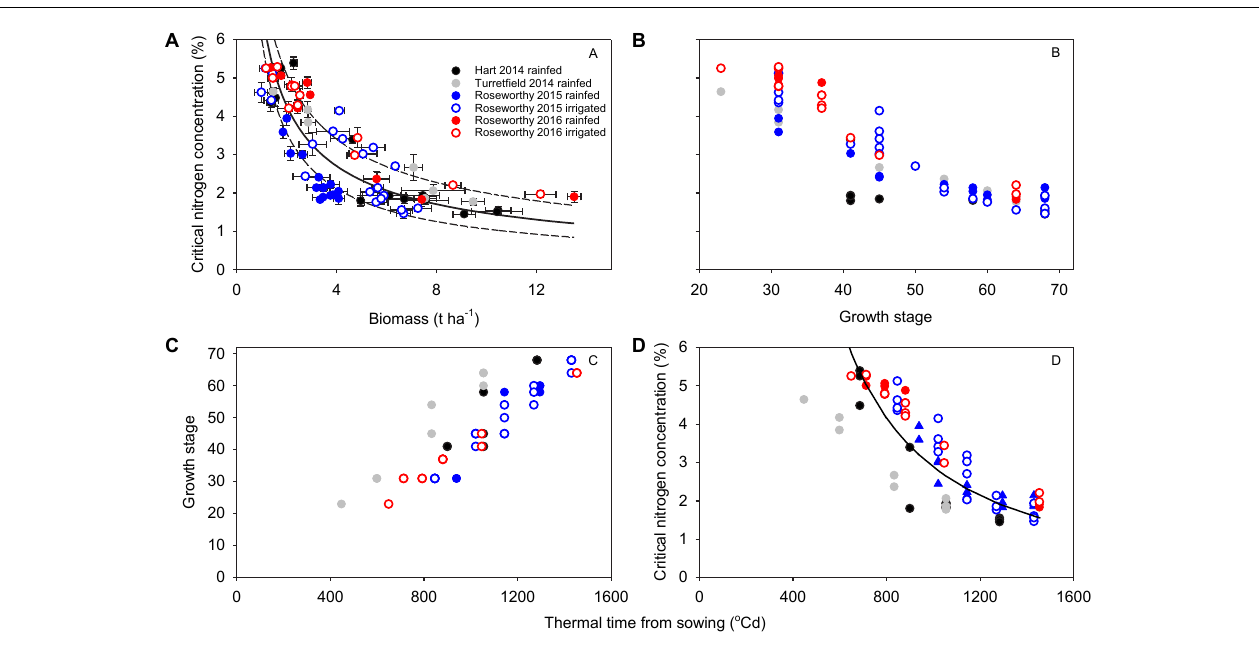
FIGURE 4 | (A) Wheat critical nitrogen concentration vs. biomass, where the fitted model (solid line) is %Nc = 6.75 ∗ W − 0 . 66 (R 2 = 0.77, P < 0.0001) and the 95% confidence intervals (dotted lines) are %Nc = 7.61 ∗ W − 0 . 58 (upper) and %Nc = 5.99 ∗ W − 0 . 75 (lower). (B) Critical nitrogen concentration vs. Zadoks’ growth stage. (C) Relationship between growth stage and thermal time from sowing. (D) Critical nitrogen concentration vs. thermal time from sowing, where the fitted model is %N c = 2.4 ∗ 10 5 ∗ thermal time − 1 . 64 (R 2 = 0.82, P < 0.0001); the scatter of data did not allow to fit confidence intervals.